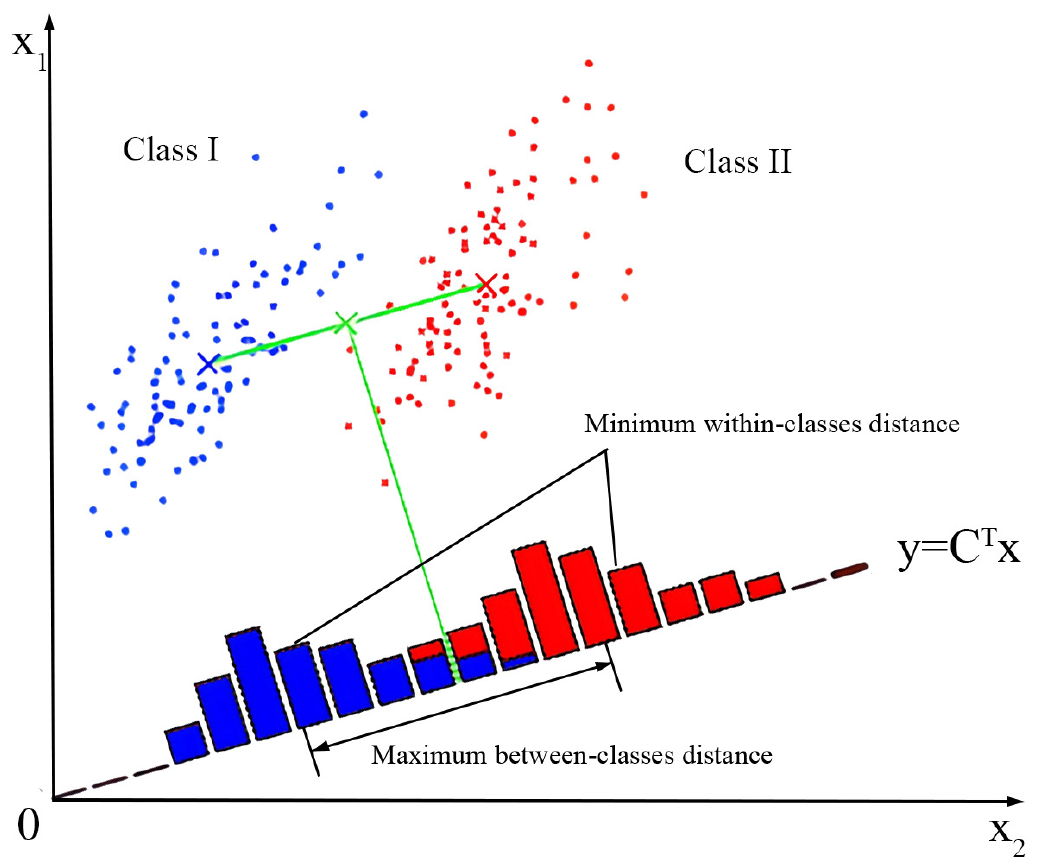
Figure 1. Schematic of Fisher discriminant analysis.